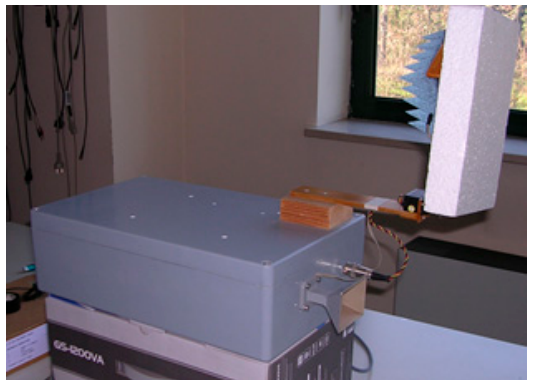
Figure 2. The microwave radiometer prototype